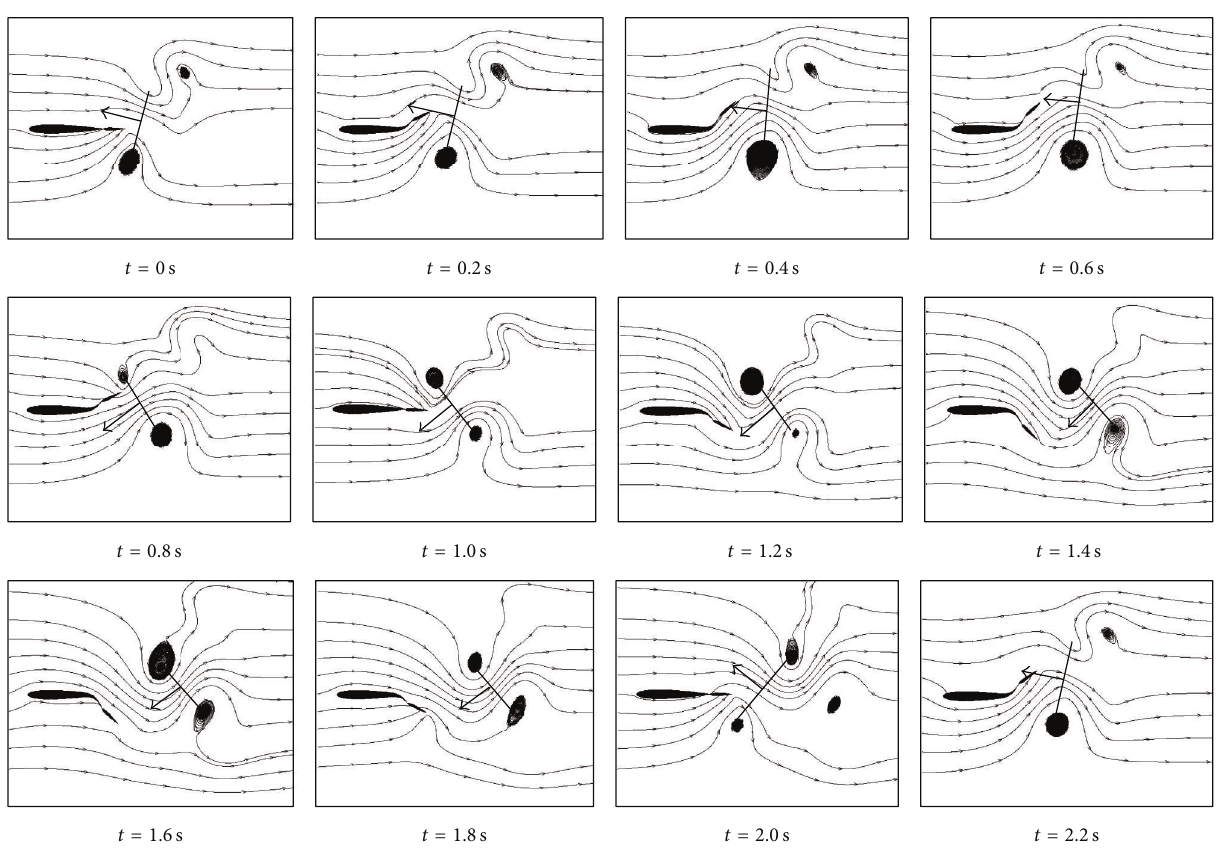
Figure 13: Trailing vortex for the optimal parameters